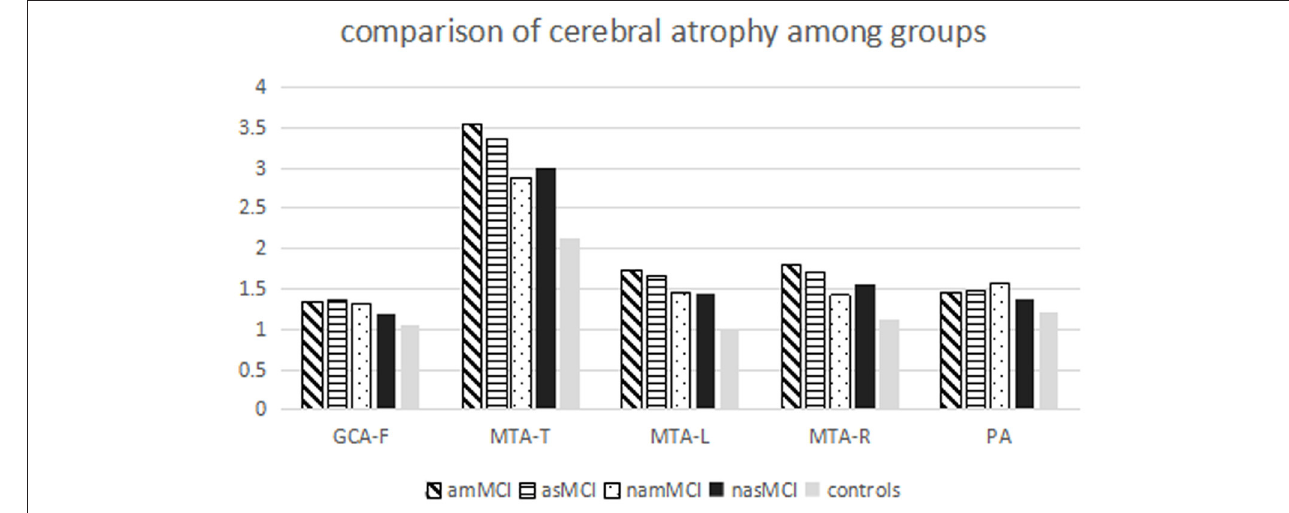
FIGURE 2 | Comparison of cerebral atrophy among all